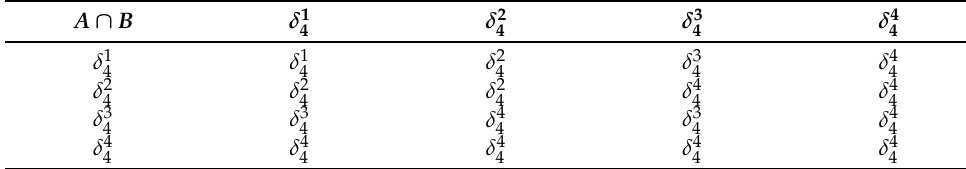
Table 4. Intersection in vector